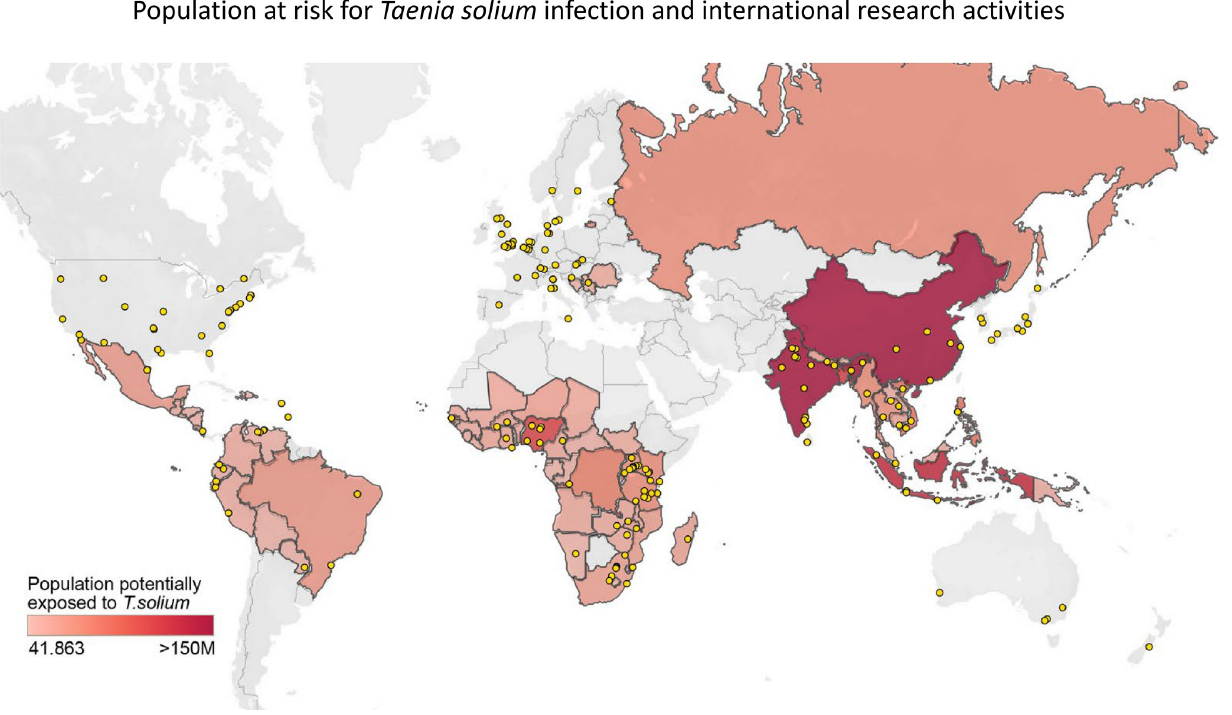
Fig 3. Mapping of information on Taenia solium transmission versus size of population with an increased risk for taeniasis. The color scheme indicates the size of the population exposed to T . solium , with dark red indicating a large population at risk for infection. The color code has been generated through a combination of epidemiology data from the WHO and the indices for living conditions provided by the World Bank. Each yellow dot represents a location mentioned in a publication about T . solium prevalence. Sources: Base map and data were obtained from OpenStreetMap and OpenStreetMap Foundation. The map contains information from OpenStreetMap and OpenStreetMap Foundation, which is made available under the Open Database License (https://www.openstreetmap.org/#map=2/20.5/22.0).